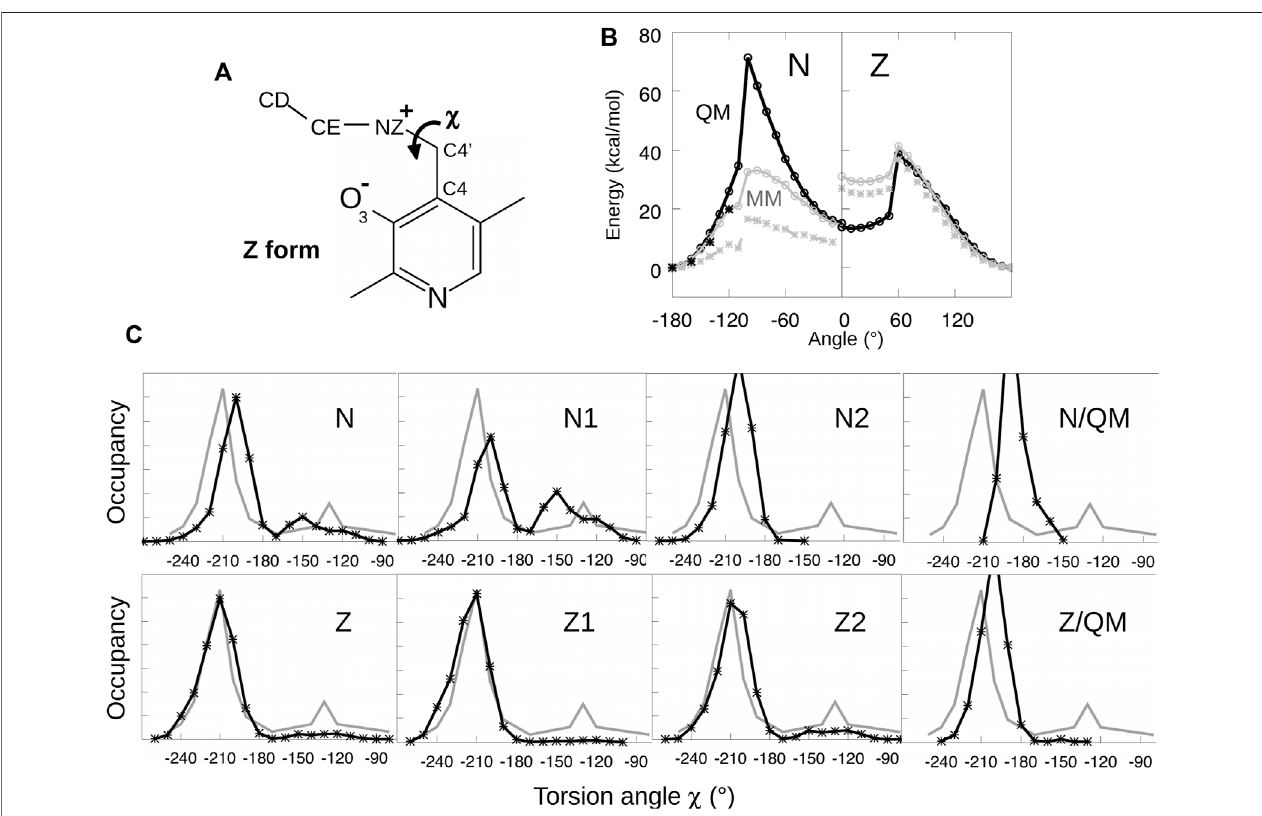
FIGURE 3 | Parametrizing the Schiff base torsion angle χ = C4-C4 ′ -NZ-CE. (A) Model compounds for N and Z states. (B) Energy as a function of χ from quantum mechanics (black) and molecular mechanics (gray). Black crosses are from QM calculations at the MP2 level. The MM calculations used parameters tuned to fi t the QM curves or the PDB data. (C) Probability distribution of χ from PDB structures (gray) and MD simulations of the PLP:MGL complex